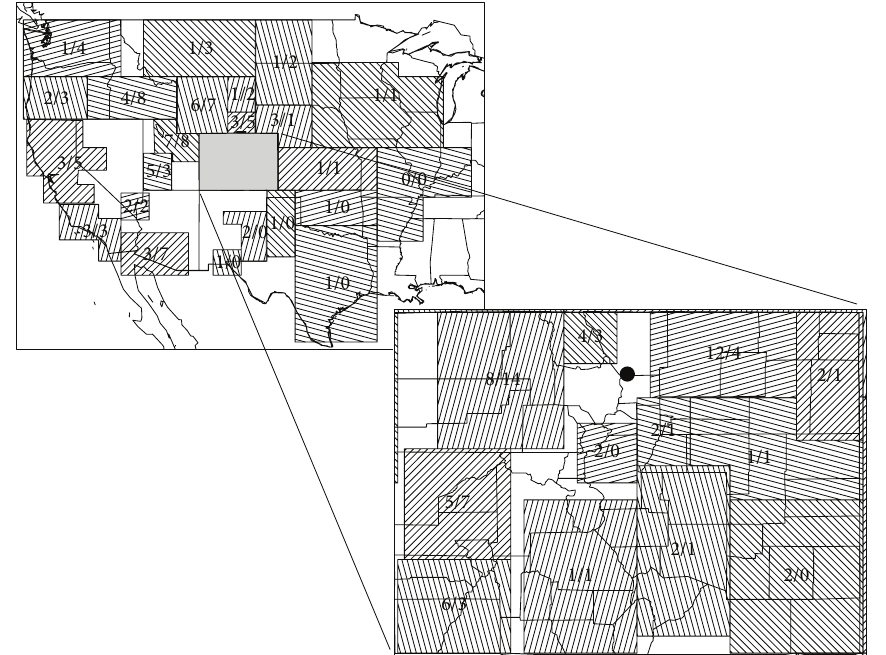
Figure 12: Source areas for TrMB modeling of ammonia. Top left is the Western US; the inset on the lower right is Colorado. County boundaries and the receptor site are shown in the inset. The numbers are the annual mean TrMB percent ammonia attribution in the numerator calculated as in the bottom row of Table 4 and the percent of back trajectory endpoints in the denominator. Values are rounded to the nearest integer; all areas had at least a fraction of a percent of the total